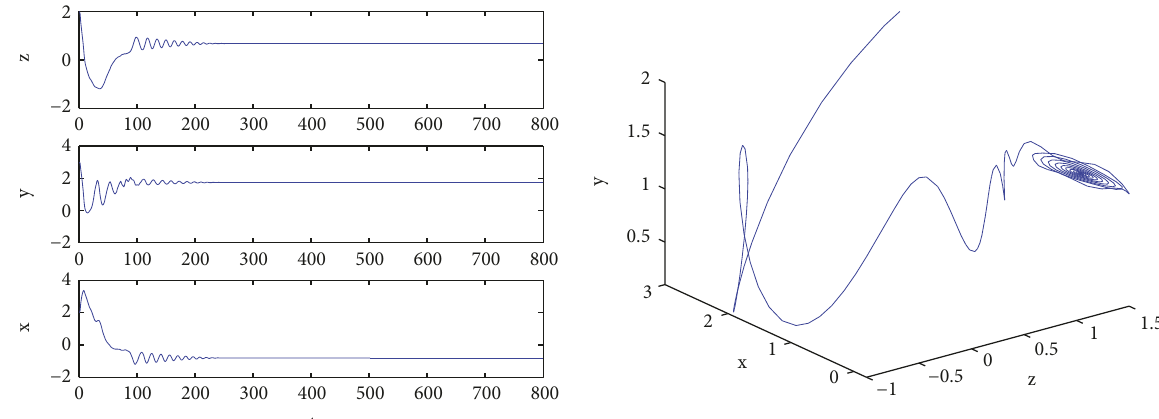
Figure 9: E ∗ + becomes stable and chaos disappears with 𝜏 1 = 0.1 and 𝜏 2 = 1.8 .